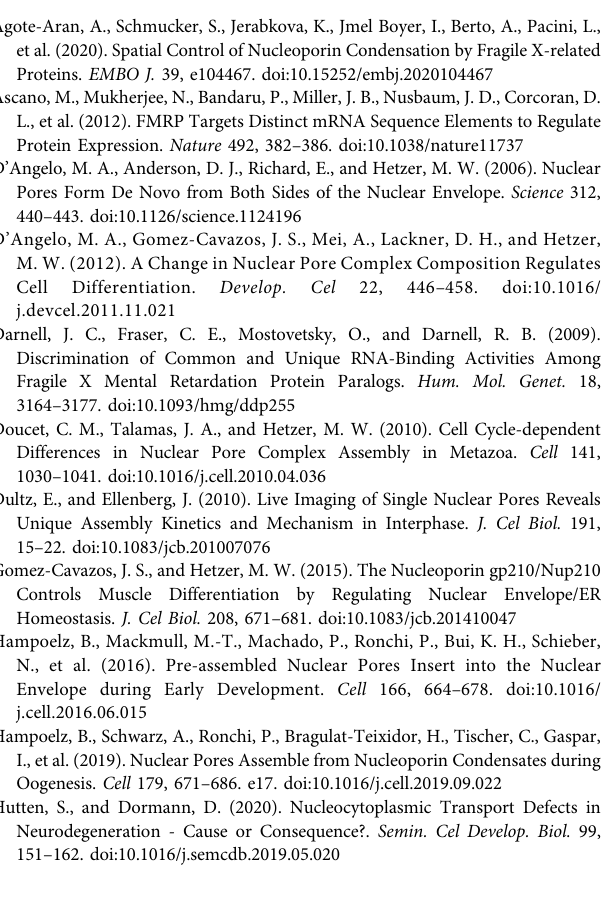
selected frames are shown in Figure 4C .